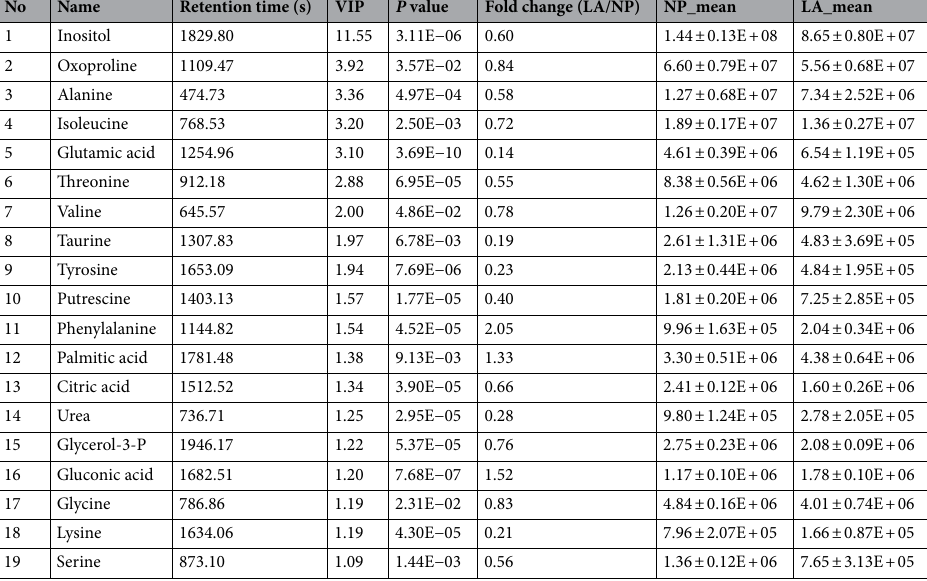
Table 2. Relative concentration of significantly changed metabolites in MDA-MB-231 cultured at pH 6.5 with 10 mmol/L lactate (mean +